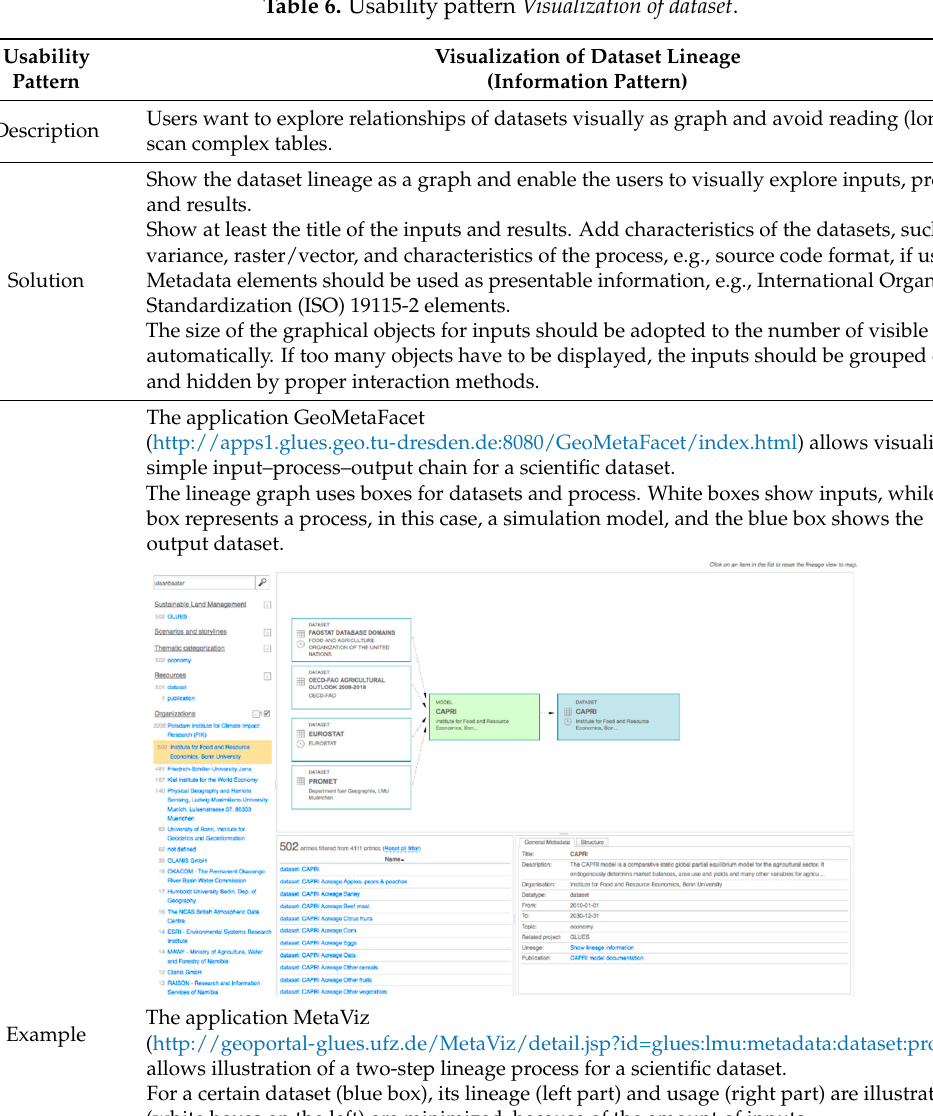
Table 6. Usability pattern Visualization of dataset